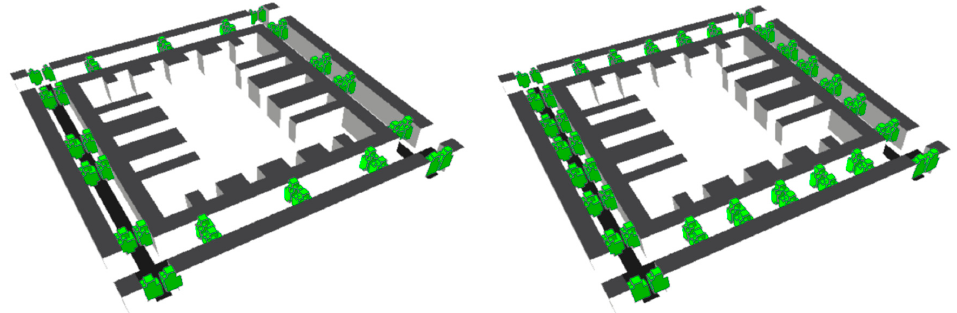
Figure 4. Passive green scenarios.